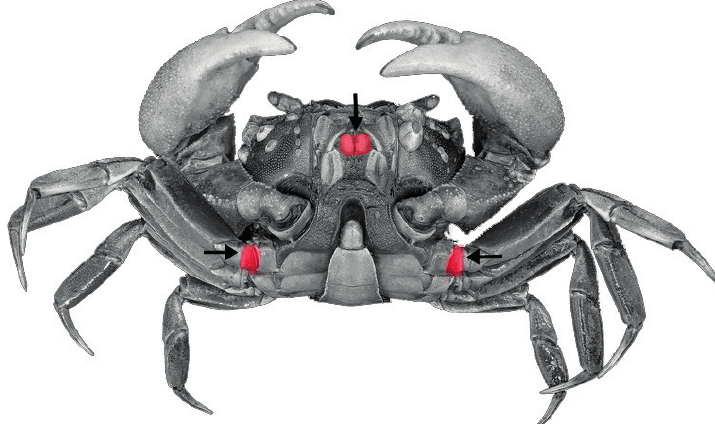
Figure 1 - Sites of injection (arrows) used in this study.